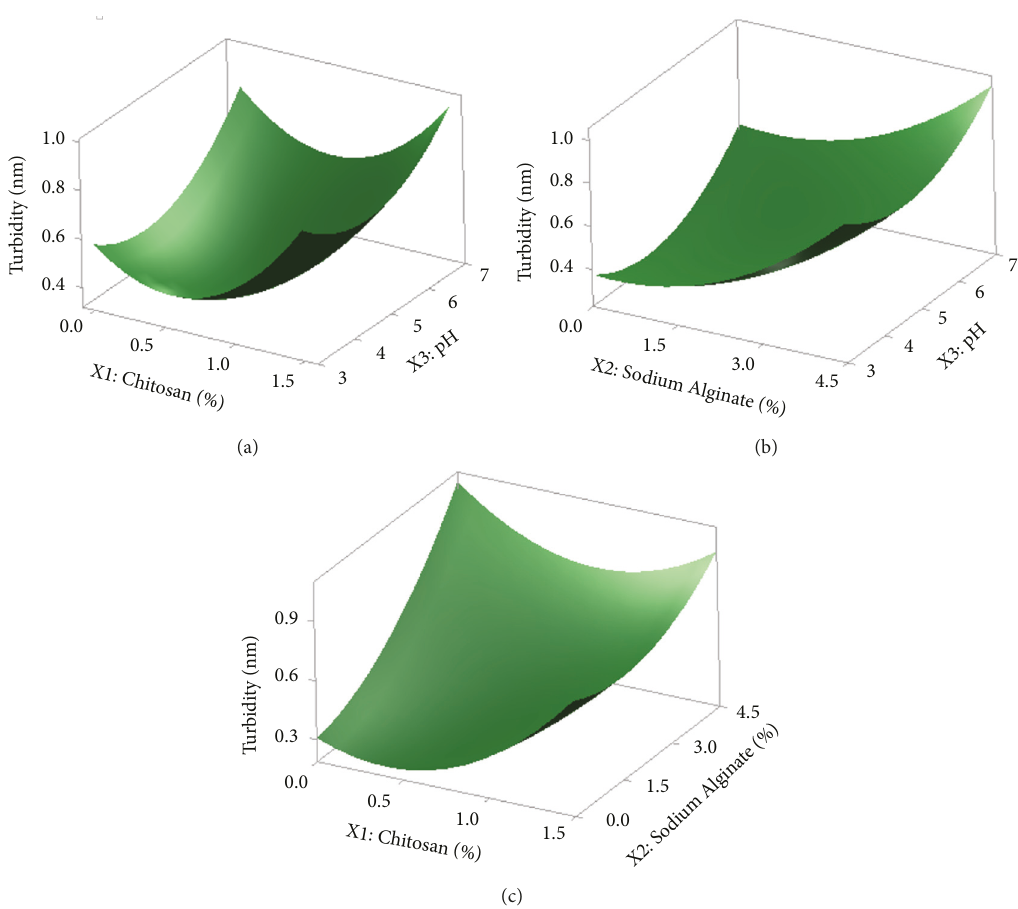
Figure 2: Three-dimensional plot of turbidity of emulsion. (a) Turbidity vs. chitosan concentration. (b) Turbidity vs. sodium alginate concentration. (c) Turbidity vs. chitosan concentration and sodium alginate